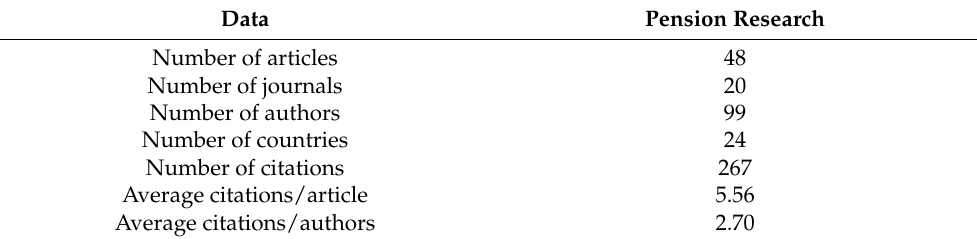
Table 11. Summary of data on pension research in the area of